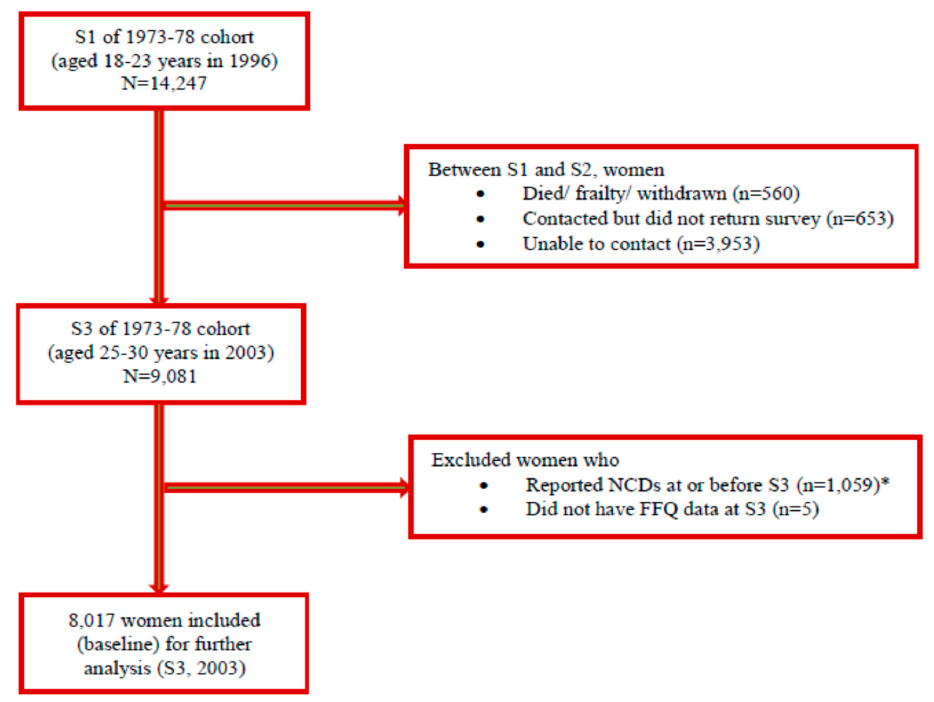
Figure 2. Diagram showing participants’ sampling from the Australian Longitudinal Study on Women’s Health (ALSWH), born in 1973–78. * NCDs at or before S3 were coronary heart disease, hypertension, cancer and diabetes mellitus .